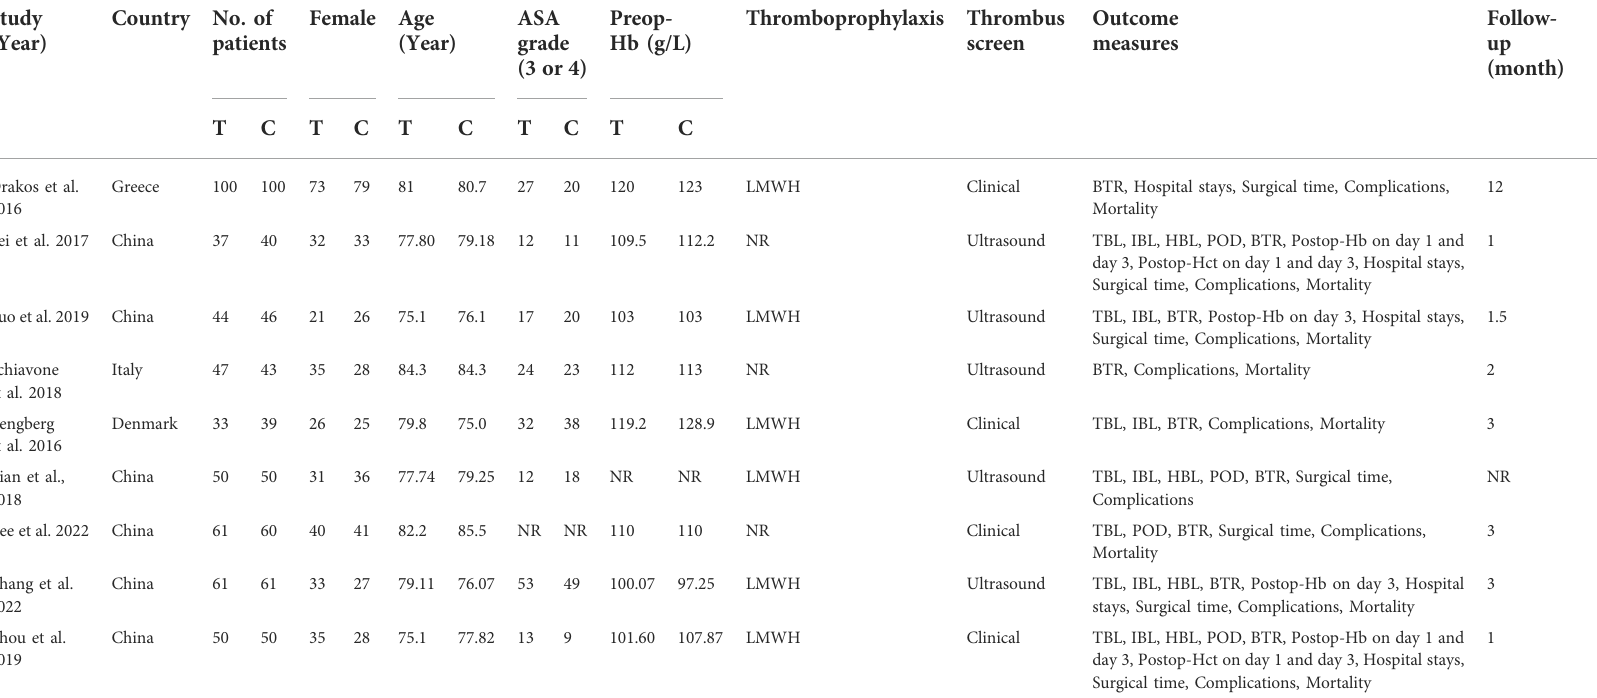
TABLE 1 The main characteristics of the included